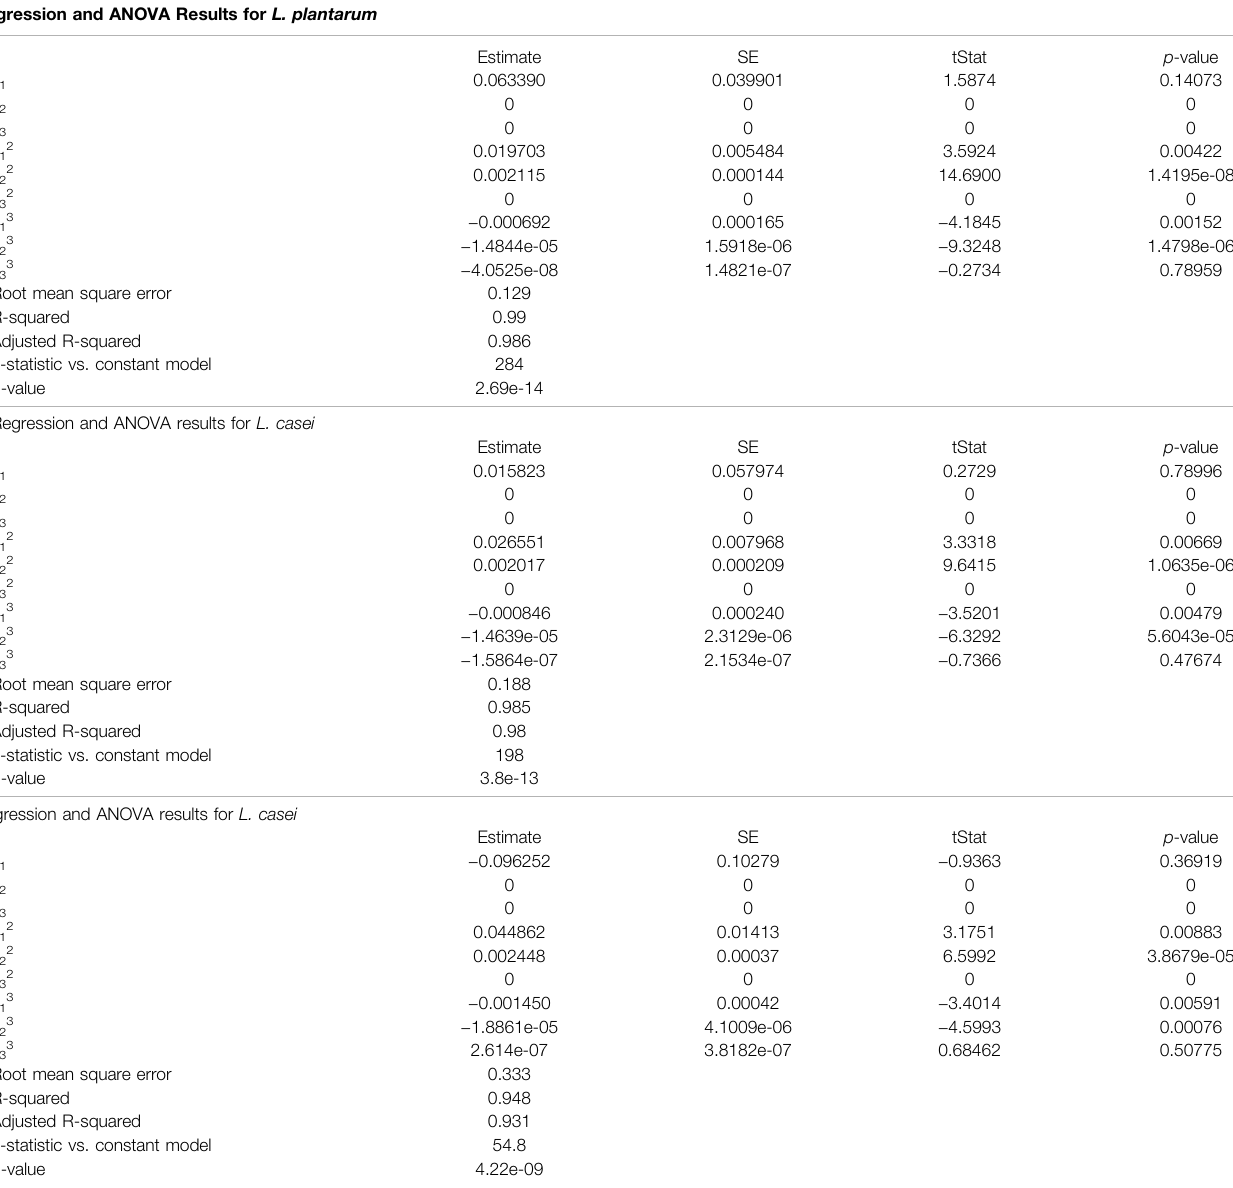
TABLE 2 | Regression and ANOVA results. Regression and ANOVA Results for L. plantarum